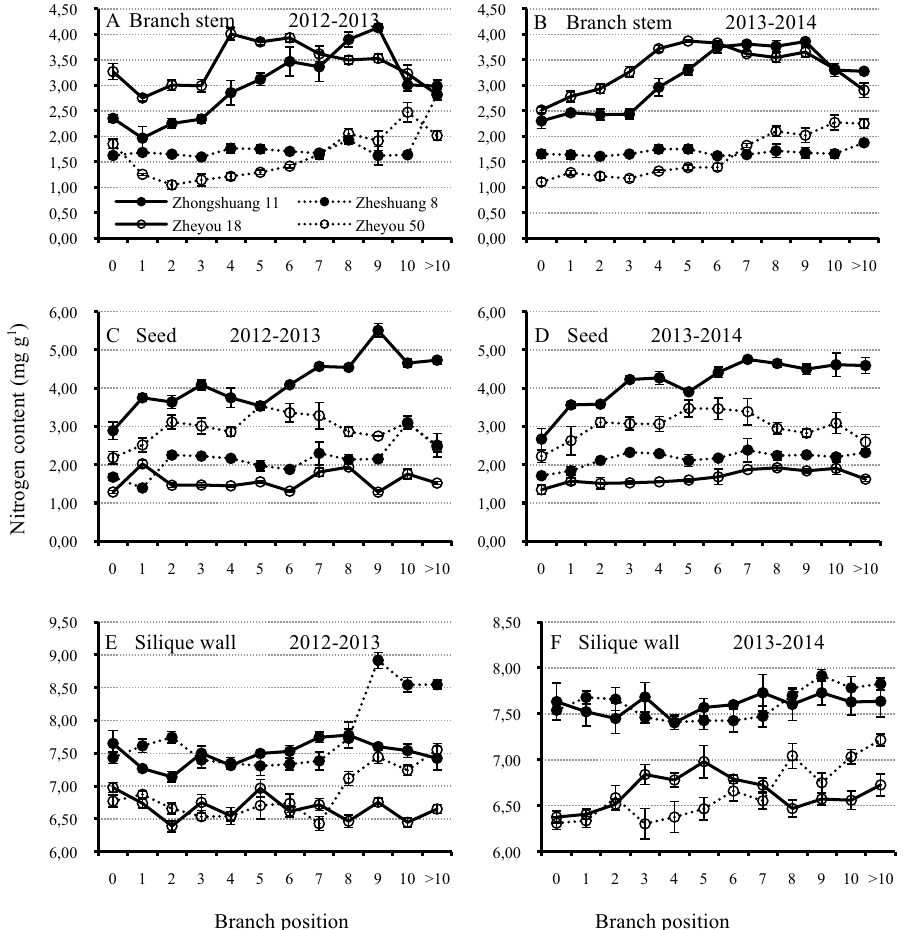
Fig. 6: Nitrogen content in the main inflorescence and different branches from the top to the bottom of the main stem in the branch stem in (A) 2012-2013 and (B) 2013-2014, seed in (C) 2012-2013 and (D) 2013-2014, and silique wall in (E) 2012-2013 and (F) 2013-2014 growth seasons in the four cultivars, Zheyou 50, Zhongshuang 11, Zheyou 18, and Zheshuang